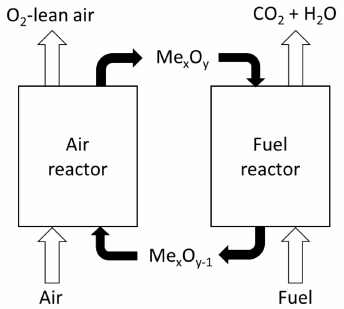
Figure 1. Schematic description of CLC.